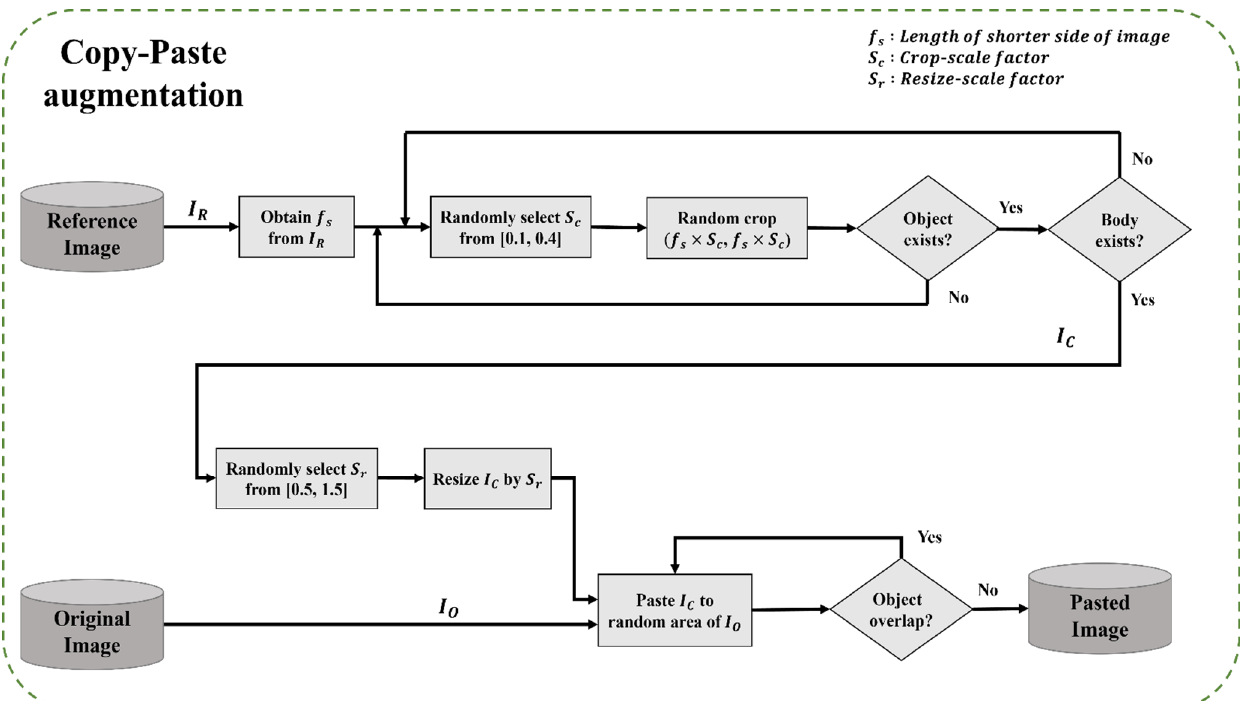
Figure 4. The pipeline of our Copy-Paste